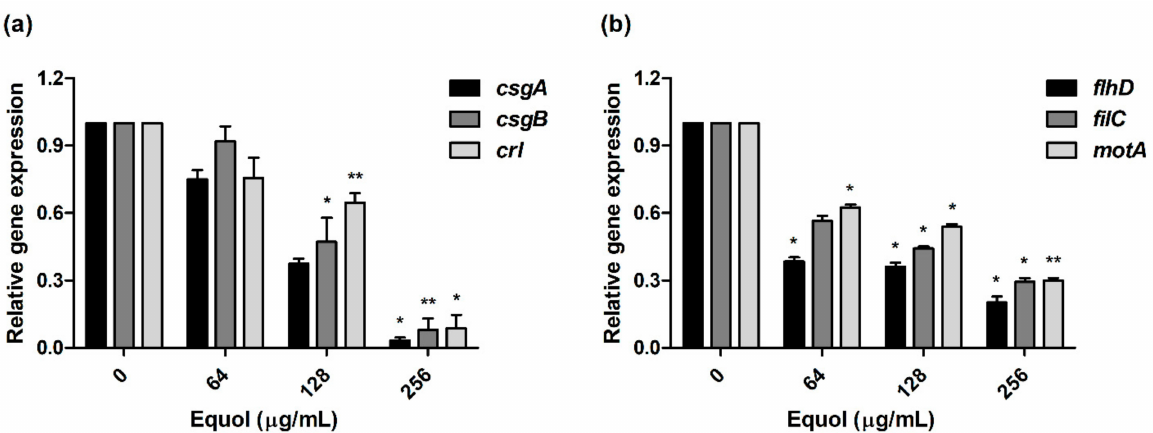
Figure 5. Transcriptional changes in the virulence-related E. coli genes. ( a ) Curli-related ( csgA , csgB, and crl ) genes and ( b ) motility-related ( fihD , filC, and motA ) genes. After treatment with various concentrations of equol (64 to 256 µ g/mL), qPCR analysis of curli- and motility-related genes in E. coli KBN12P05816 was performed. The transcription levels of the target genes were normalized to that of 16S rRNA. The Student’s t -test was conducted to analyze the gene expression between the samples and the control. The error bars represent the means and standard deviations (SDs). Asterisks (*) indicate statistically significant differences (* p < 0.05 and ** p < 0.01) from the